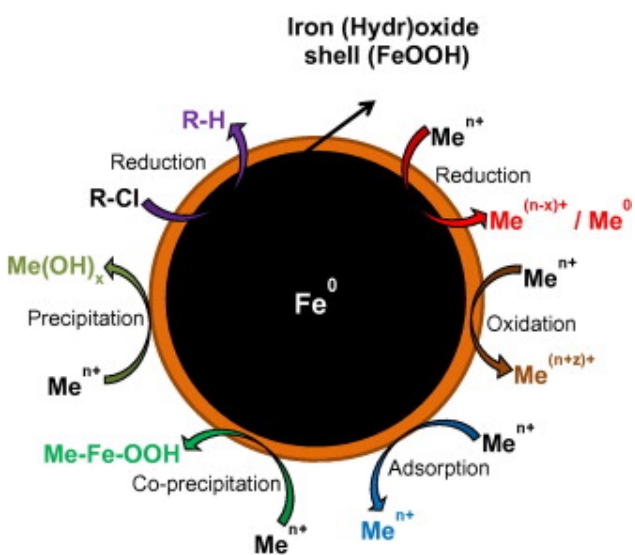
Figure 1. Summary of the degradation mechanism for chlorinated contaminant and metal removal by using NZVI. Reproduced with permission from [30]. Copyright 2013 Elsevier.